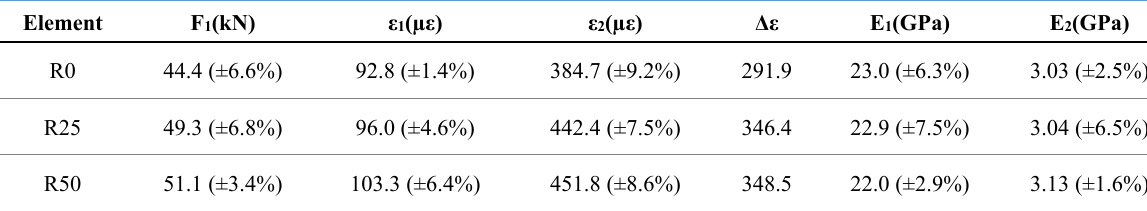
Table 3. Experimental results of tension stiffening tests.